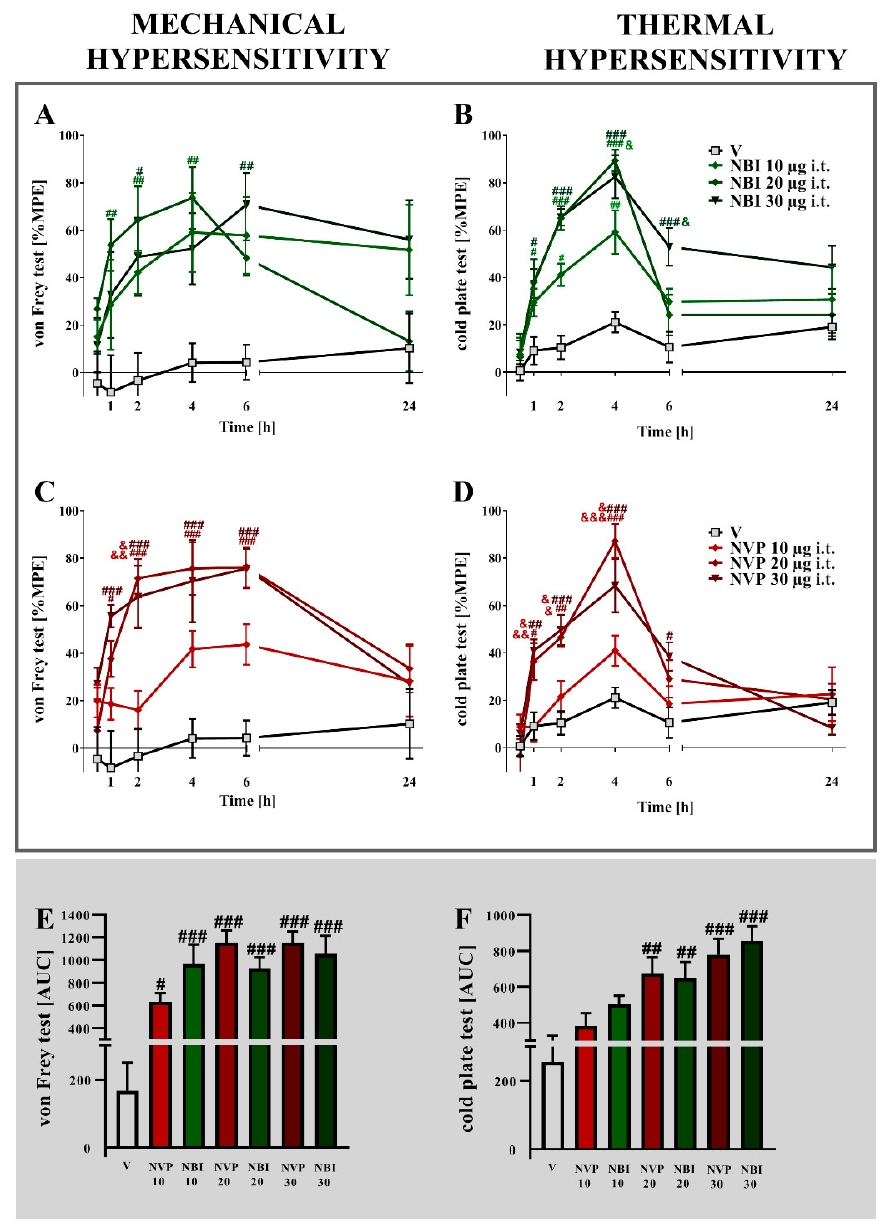
Figure 1. Comparison of the analgesic effects of intrathecal ( i.t .) administration of different doses (10, 20, or 30 µ g/5 µ L) of ( ± )-NBI 74330 ( A , B ) and NVP CXCR2 20 ( C , D ) on the 7th day after chronic constriction injury in rats. The effects of single i.t. NBI and NVP injections on mechanical ( A , C ) and thermal ( B , D ) hypersensitivity were measured. The results are presented as a percentage of the maximal possible effect (% MPE = (post-drug response − basal response)/(cutoff value − basal response) × 100%) of drug action ( A – D ), and the area under the curve (AUC) for each test was calculated ( E , F ). Data are presented as the means ± SEM (4–6 rats per group). The results were evaluated using one-way ANOVA followed by Bonferroni’s test for comparisons of selected pairs measured separately at each time point. Additionally, the results were evaluated using two-way ANOVA to determine the time × drug interaction. # p < 0.05, ## p < 0.01, and ### p < 0.001 for the comparison of vehicle-treated animals with all groups at the indicated time points. & p < 0.05, && p < 0.01, and &&& p < 0.001 for the comparison of different NBI or NVP doses, and the same doses of NVP with NBI. Abbreviations: vehicle, V; (±)-NBI 74330, NBI; NVP CXCR2 20, NVP.